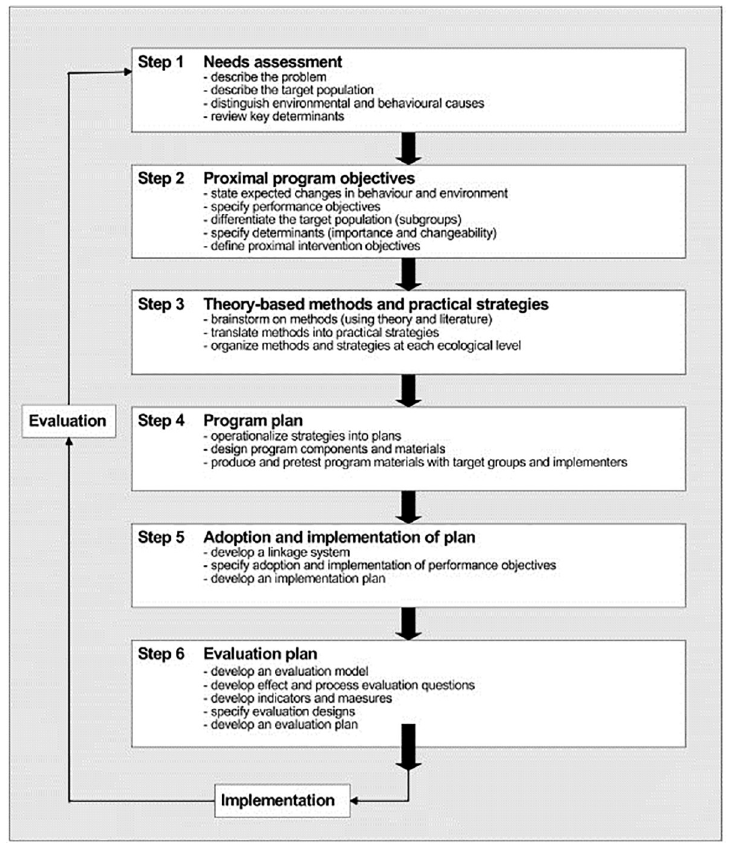
Fig 1. The six steps of the Intervention Mapping process